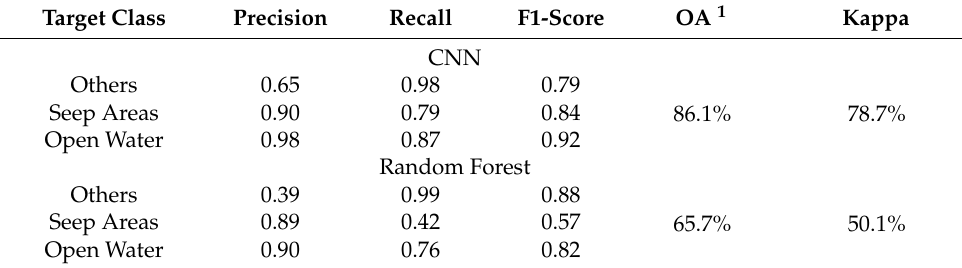
Table 1. Accuracy assessment of seep area maps produced by CNN and